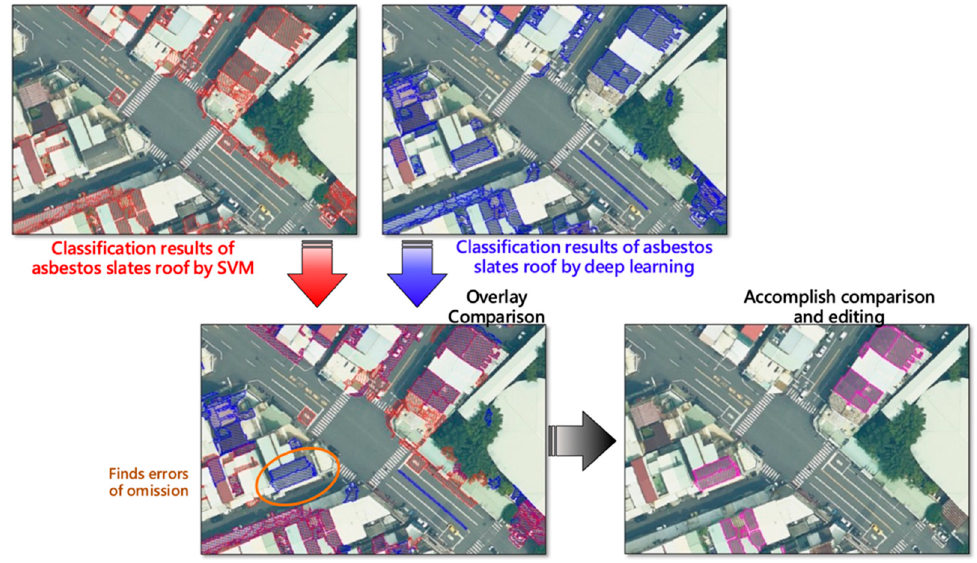
Figure 6. Overlapping two classifications and pixel growing to detect the existence of roofing area.